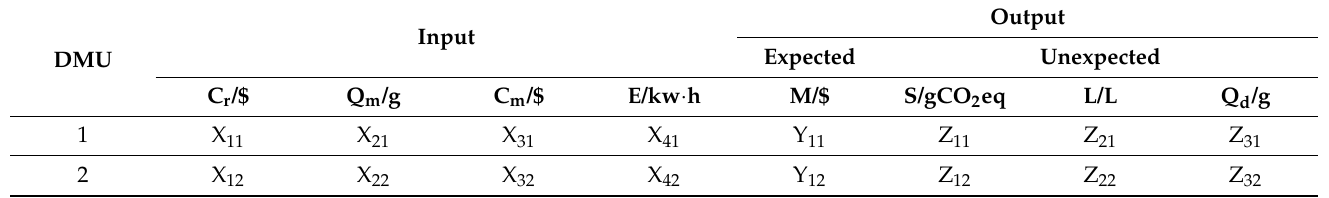
Table 1. The DEA input and output indexes of resource utilization efficiency in the machining process.